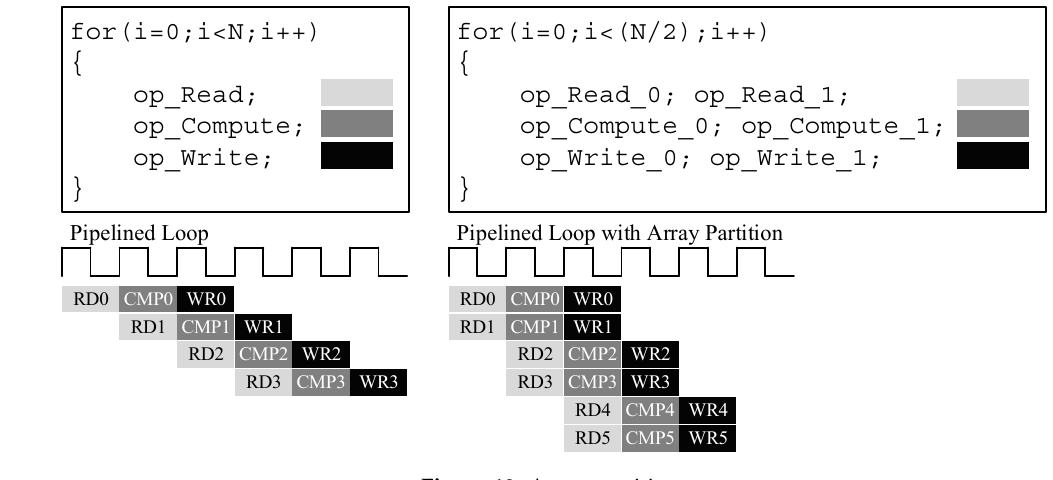
Figure 10. Array partition.